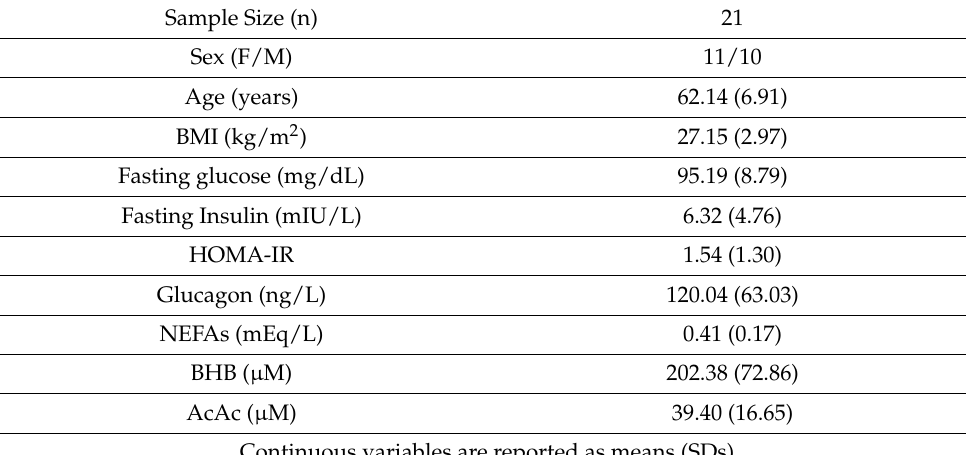
Table 1. Baseline demographic and laboratory